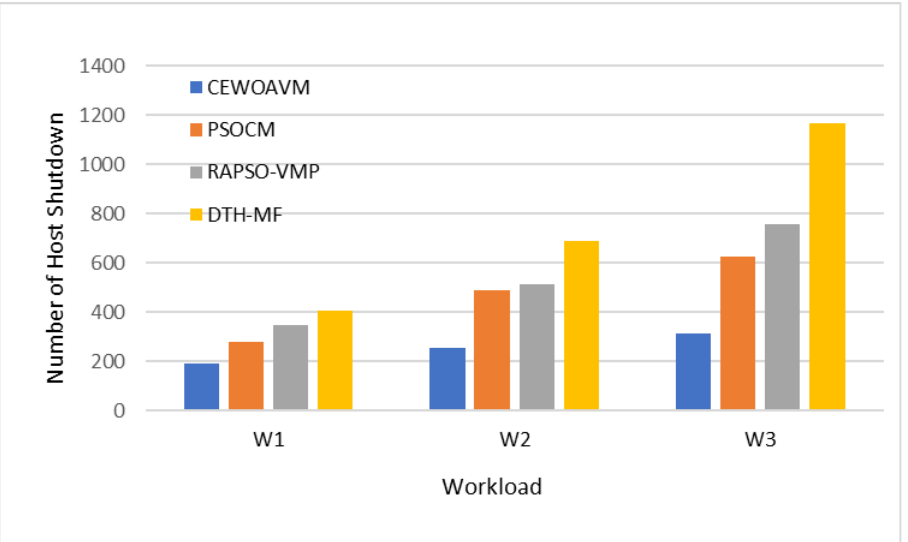
Figure 7. Comparison analysis of host shutdowns.